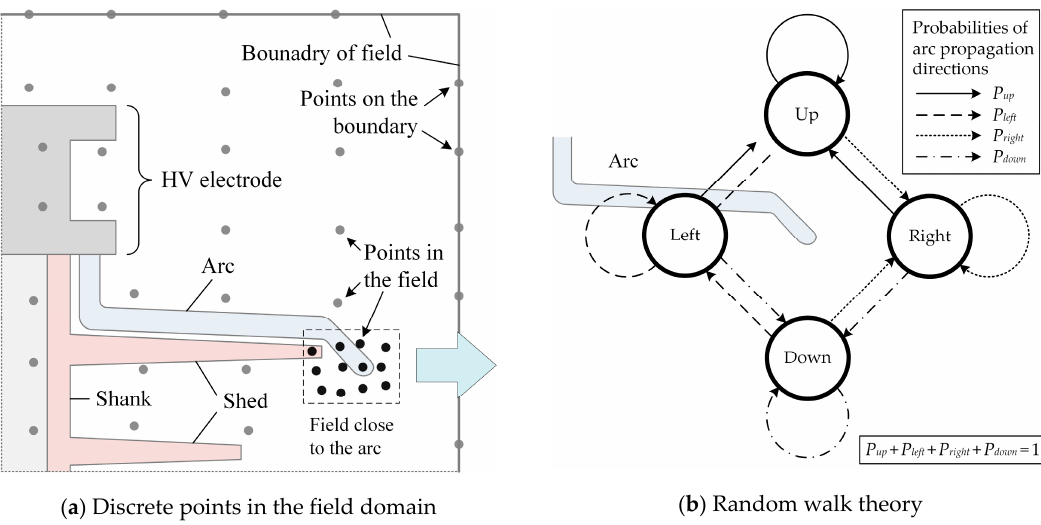
Figure 2. Electric field calculation of the discretized points and arc propagation model based on the random walk theory.